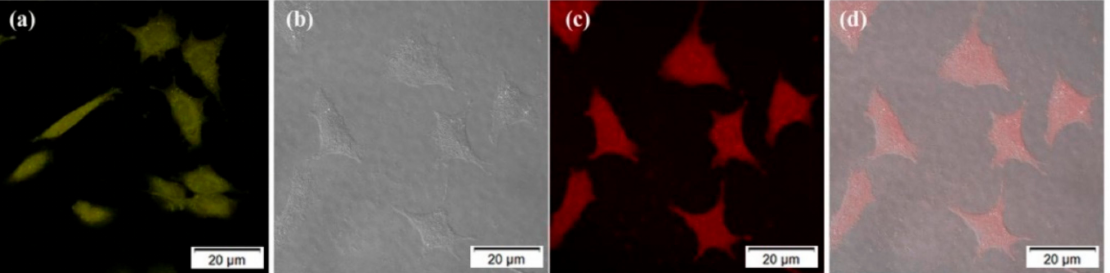
Figure 11. Bioimaging of probe RCya–Pd 2+ in HeLa: ( a ) the fluorescent image of HeLa incubated with 10 µ mol L − 1 RCya for 30 min; ( b ) a further incubation of ( a ) with 40 µ mol L − 1 Pd 2+ for another 2 h at bright field; ( c ) a further incubation of ( a ) with 40 µ mol L − 1 Pd 2+ for another 2 h at dark field; ( d ) an overlay of ( b ) and ( c ). Scale bar: 20 µ